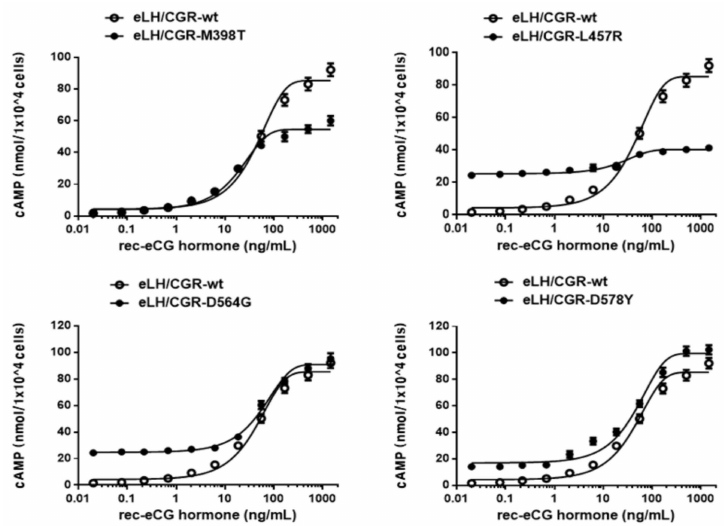
Figure 3. Total cAMP levels stimulated by recombinant eCG (rec-eCG) in CHO-K1 cells transfected with constitutively activating eLH/CGR mutants. CHO-K1 cells transiently transfected with wild- type eLH/CGR and mutants (M398T, L457R, D564G, and D578Y) were stimulated with rec-eCG in a medium containing 0.5 mM 3-isobutyl-1-methyl xanthine for 30 min. Levels of cAMP production were determined by homogeneous time-resolved fluorescence (HTRF). The cAMP accumulation was calculated as Delta F%. The cAMP concentration was recalculated and presented using the GraphPad Prism software. The results for the mock-transfected cells were subtracted from each data set. A representative data set was obtained from three independent experiments. The blank circles represent the corresponding curves for the wild-type receptor. Total cAMP was then measured in triplicate wells, as described in the Materials and Methods section. The figure depicts the results of the representative experiment performed with the indicated mutants. The lines are nonlinear least square fits of the experimental